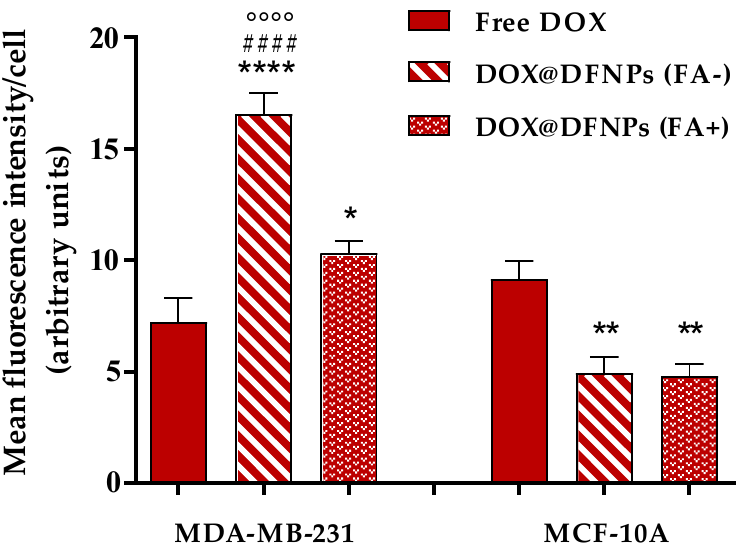
Figure 11. Quantitative analysis of red fluorescence intensity in MDA-MB-231 and MCF-10A cells (blocked-FA+ or unblocked-FA- receptors) exposed to DOX@DFNPs. Intensity of free DOX treatments was inserted as control. **** p < 0.0001 vs. free DOX; ** p < 0.01 vs. free DOX; * p < 0.05 vs. free DOX; #### p < 0.0001 vs. DOX@DFNPs (FA+); ◦◦◦◦ p < 0.0001 vs. MCF-10A cells (FA-). (One-way ANOVA followed by Tukey’s post-test; data are expressed as mean ± SD of three independent experiments).